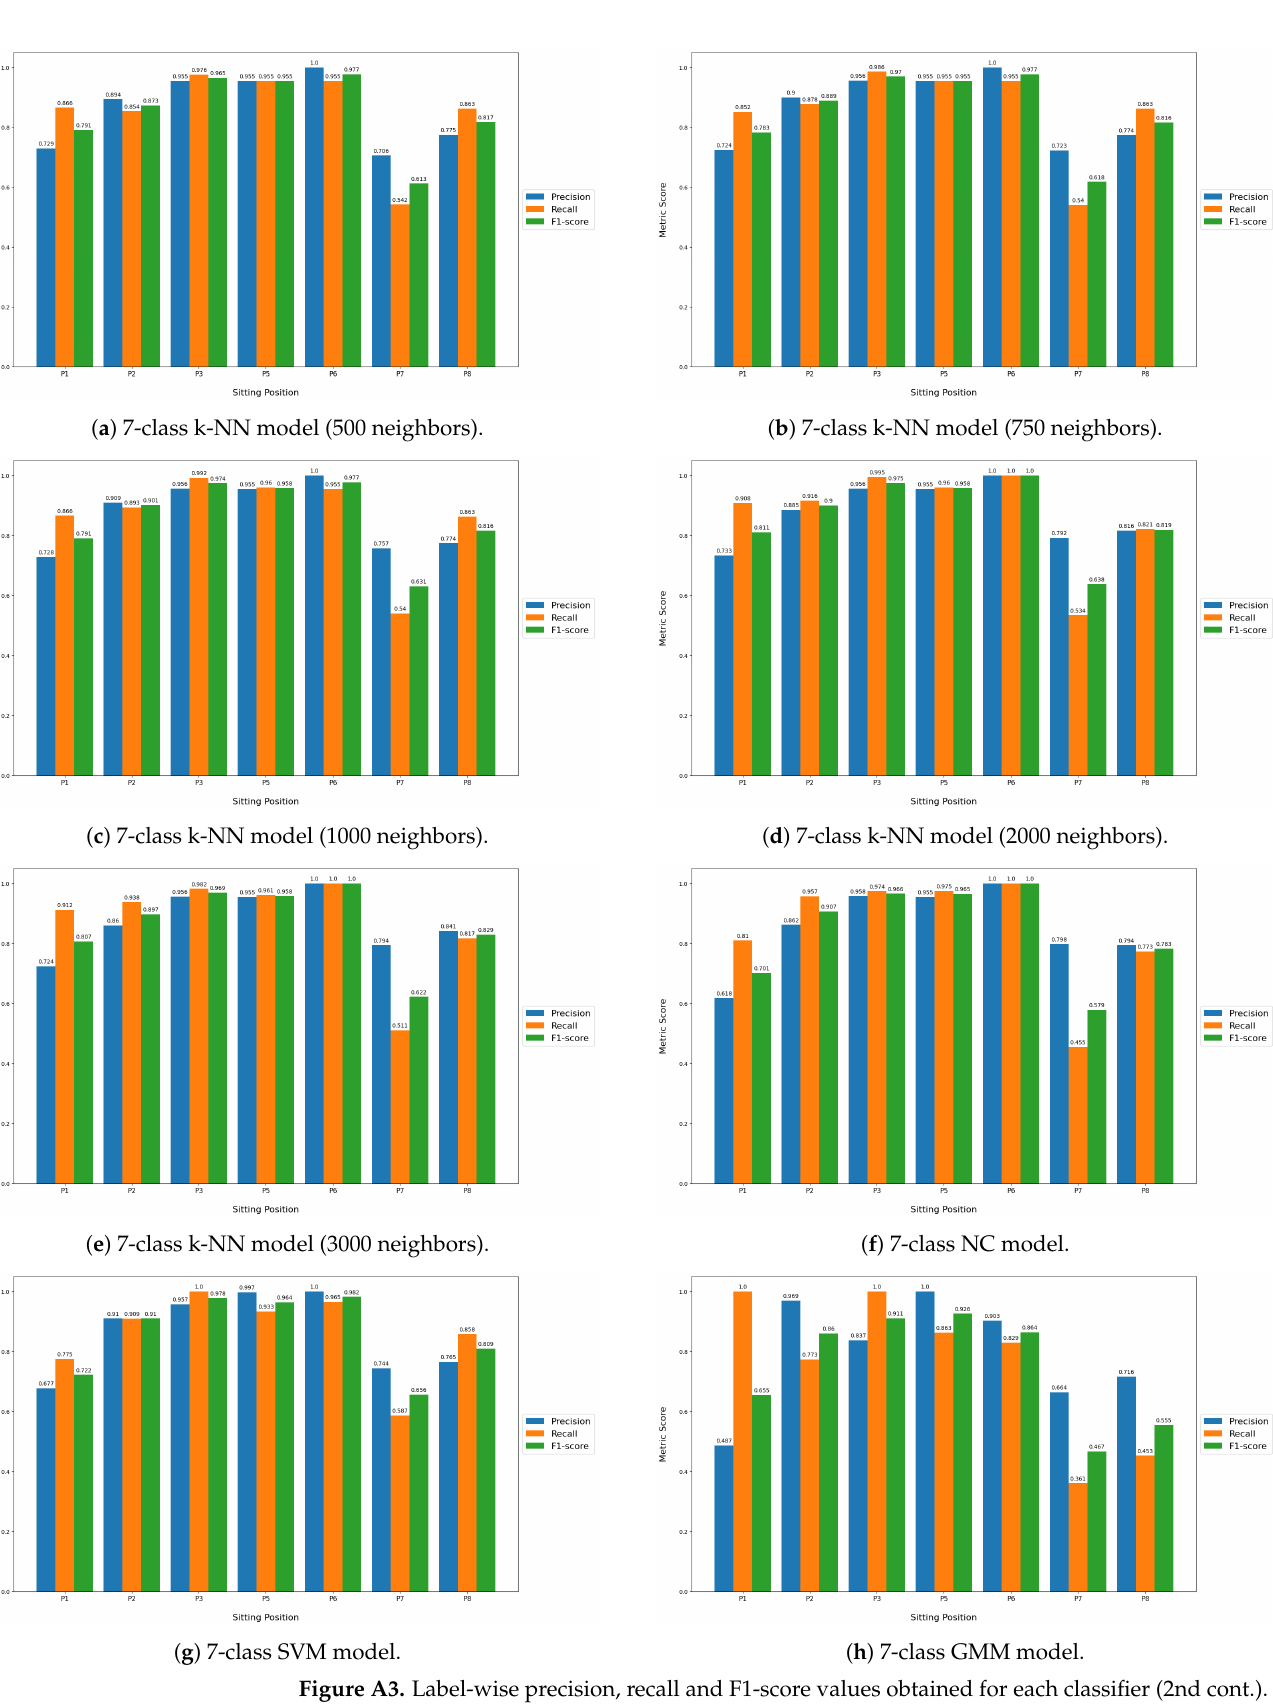
Figure A3. Label-wise precision, recall and F1-score values obtained for each classifier (2nd